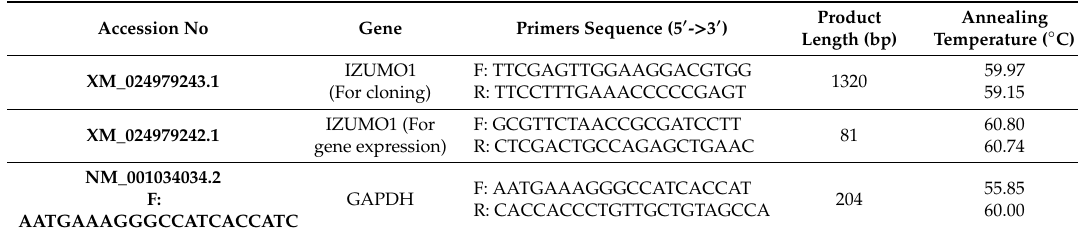
Table 1. Primers used for PCR and